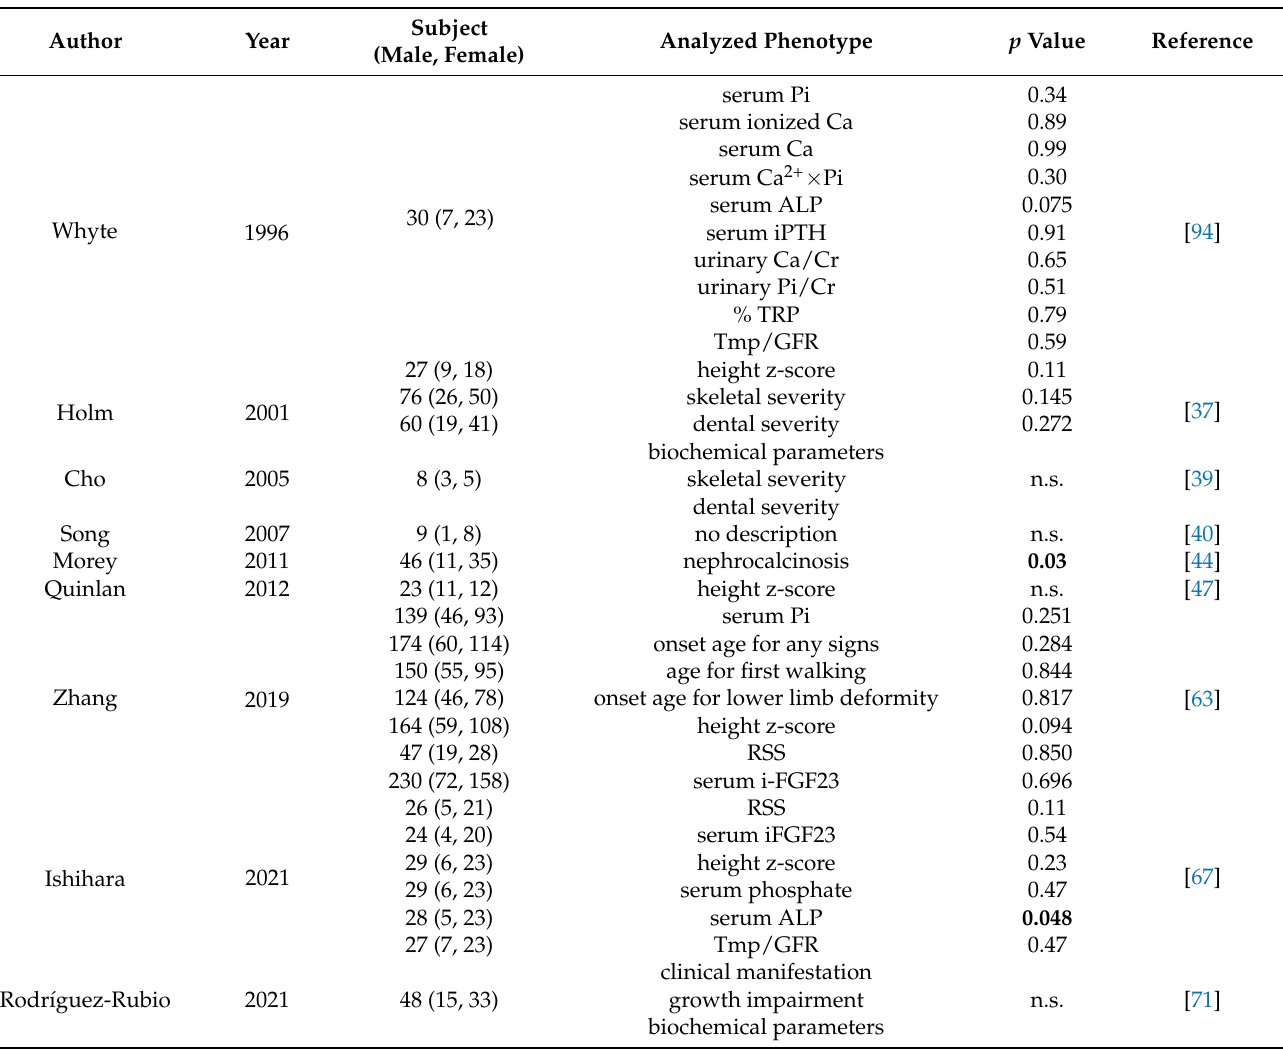
Table 2. Summary of gene dosage effect